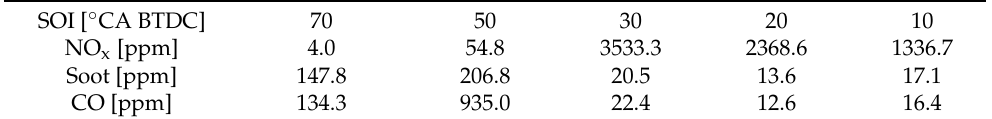
Table 5. Engine-out emissions.